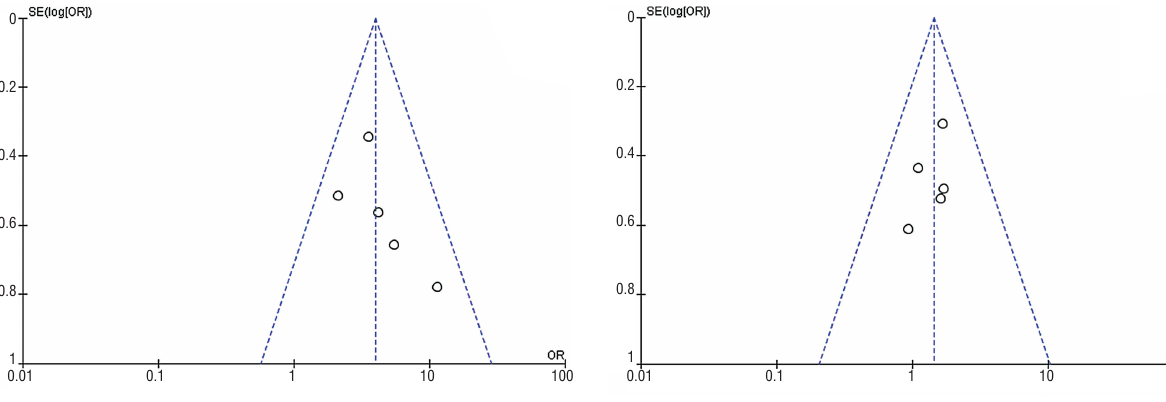
Figure 5 - Funnel plot of comparison regarding (A) final SFR and (B) overall